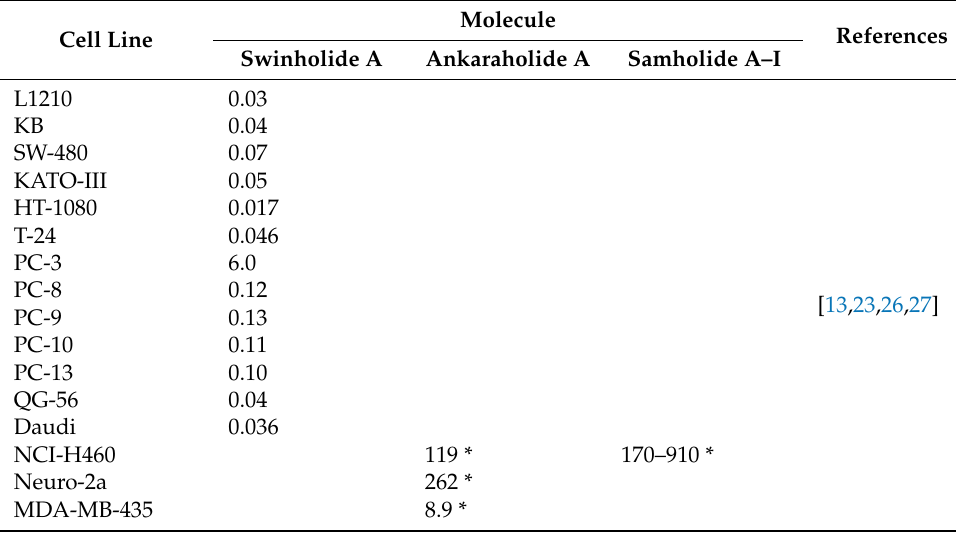
Table 3. Cytotoxic activity of the swinholide family on cancer cell lines. IC 50